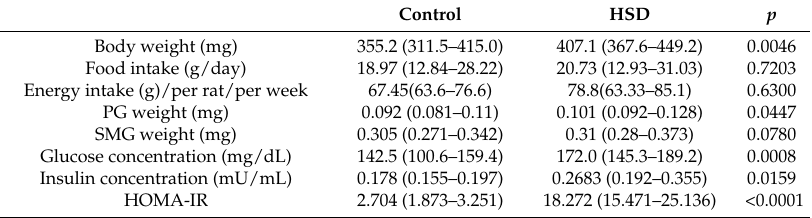
Table 1. General characteristics of the control and high-sucrose (HSD) fed